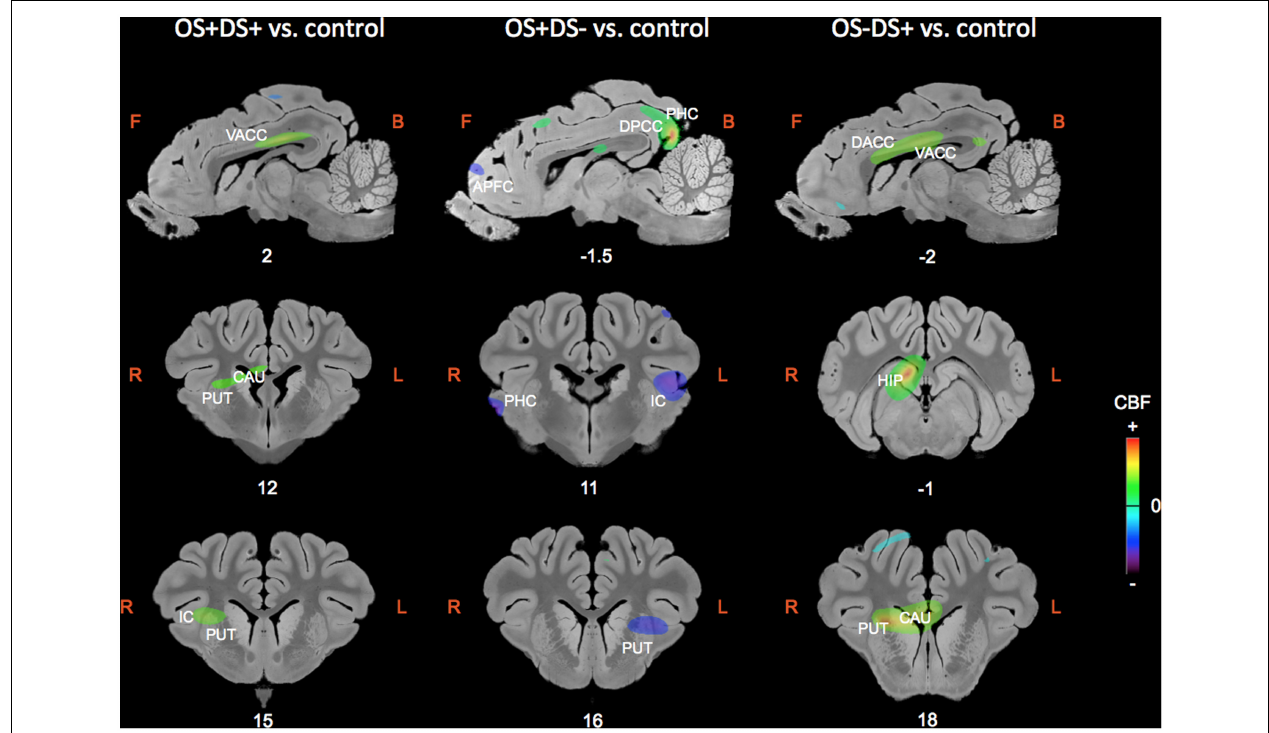
FIGURE 4 | Sagittal and coronal MRI sections showing clusters of differential cerebral blood flow identified during the small volume correction (SVC) analyses in different regions of interest chosen upon a priori hypotheses for the three following contrasts: OS + DS + (oral and duodenal sucrose stimulation) vs. control, OS + DS − (oral sucrose stimulation) vs. control, and OS − DS + (duodenal sucrose stimulation) vs. control. The x or y coordinates in the CA–CP ( commissura anterior–commissura posterior ) plane are